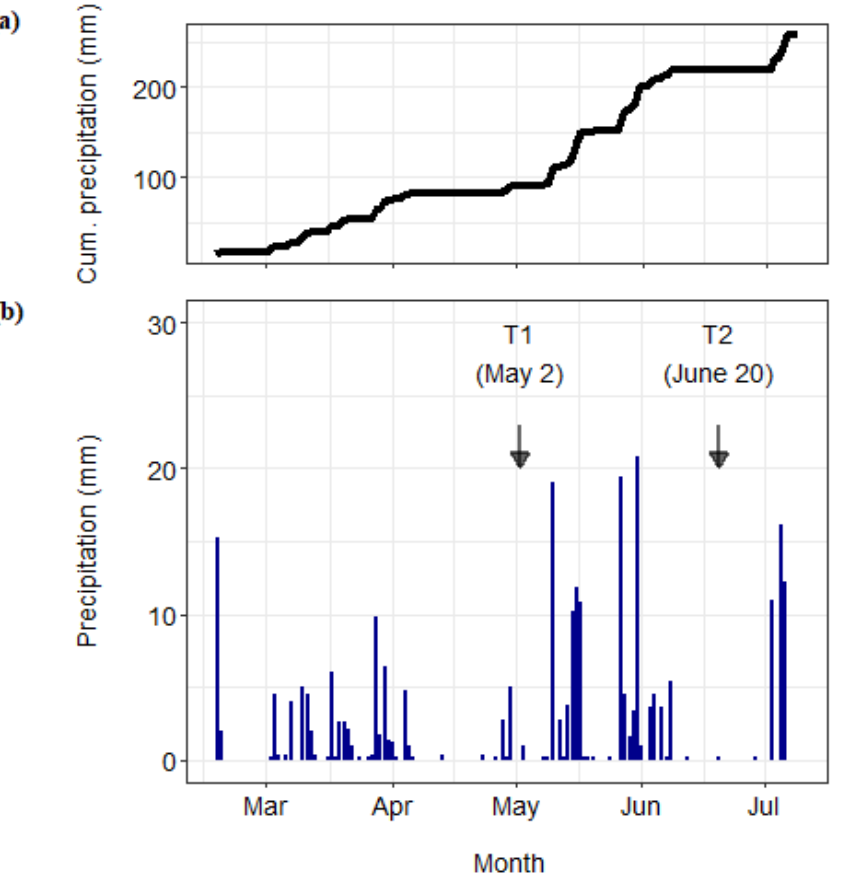
Figure 3. Natural precipitation levels at the study site: ( a ) cumulative precipitation (mm) and ( b ) total daily precipitation (mm).